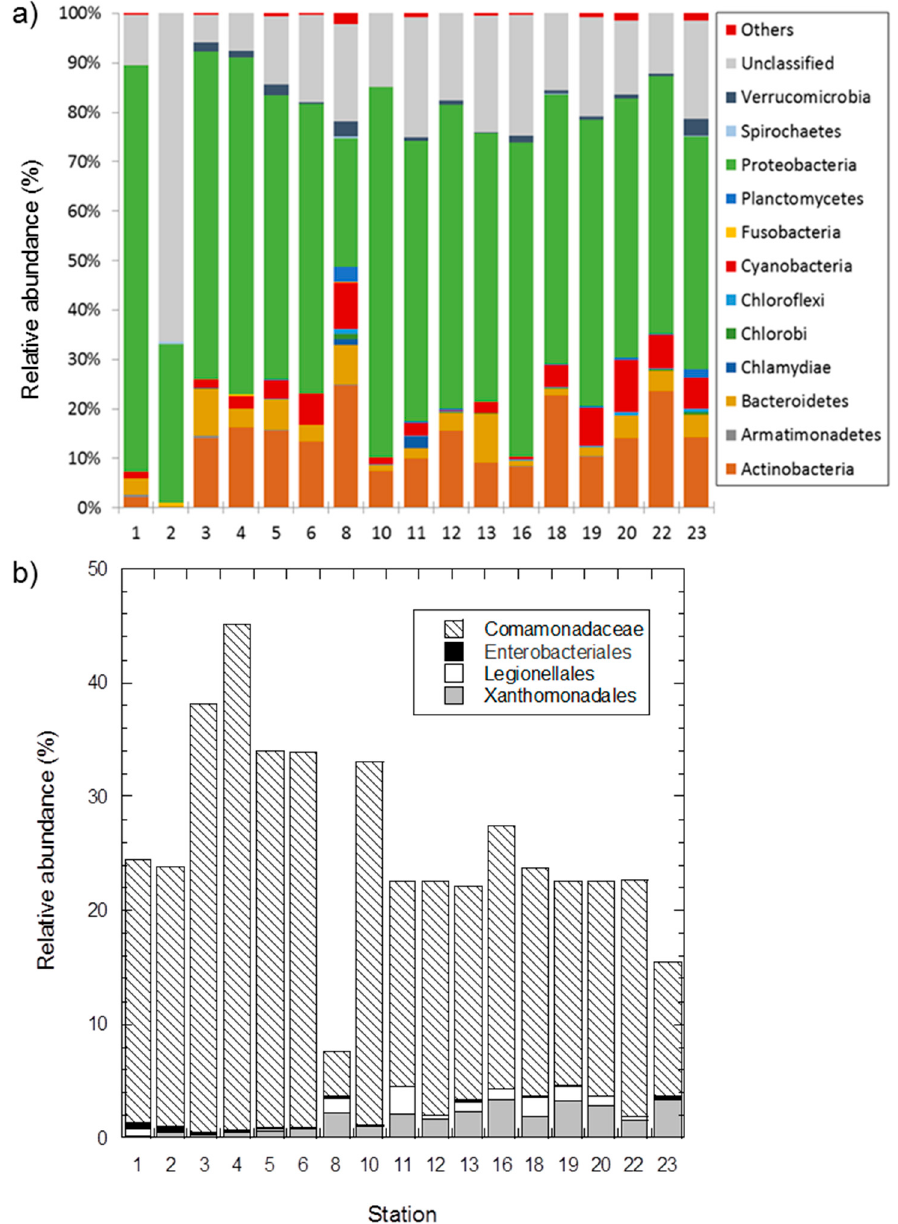
Figure 5. ( a ) Relative abundance of bacterial phyla at 17 stations along the Cauvery River. Others comprised rare phyla with less than 0.5% of the total bacterial community in a given sample; ( b ) relative abundance of potential pathogen bacterial in 17 stations along the Cauvery River (beta-proteobacteria: Comamonadaceae; gamma-proteobacteria: Enterobacteriales, Legionellales, Xanthomonadales).